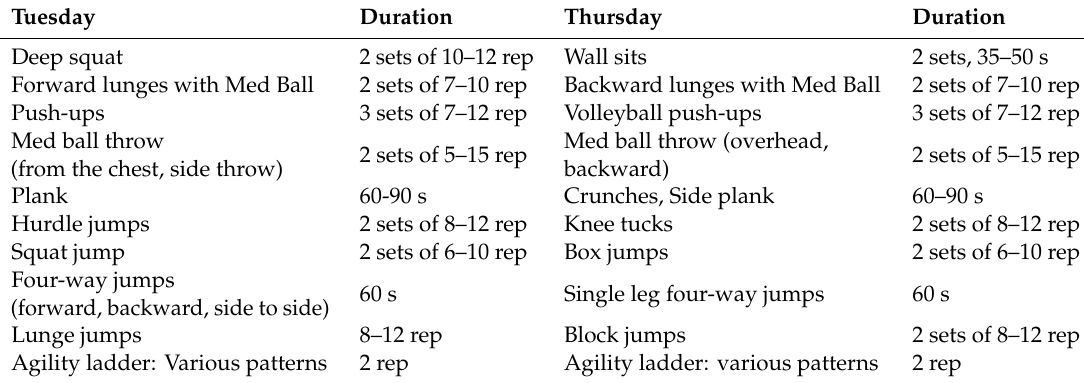
Table 2. Neuromuscular training program